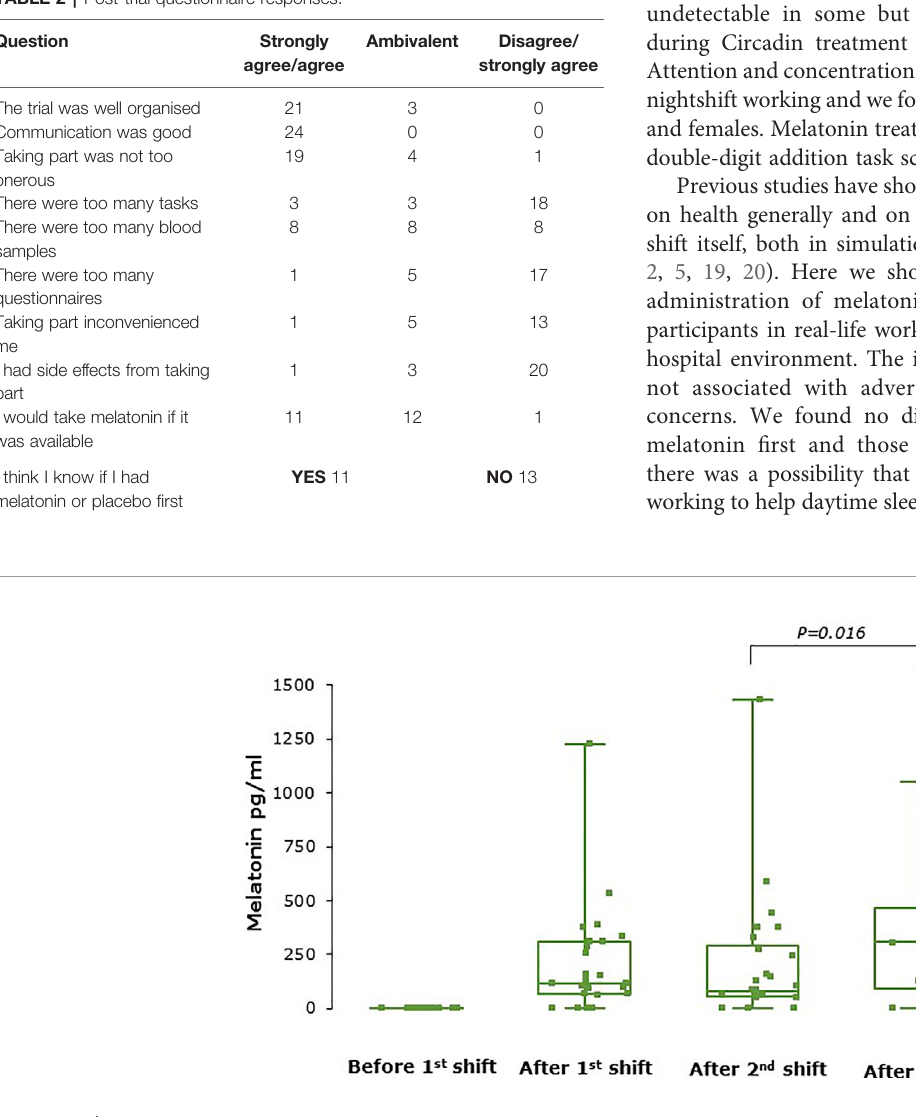
FIGURE 3 | Serum melatonin concentrations at baseline and after each shift during the melatonin arm (n = 25). Levels increased signi fi cantly over the series of shifts (P = 0.01 overall) and were higher after shift 3 than shift 2 (P = 0.016). Melatonin levels were not detectable at baseline in any participant. Box and whisker plots show median, interquartile, and full range with individual data points overlaid (n = 25).